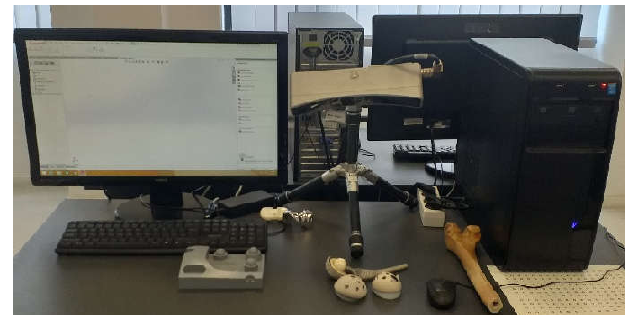
Figure 17. 3D Geomagic Capture